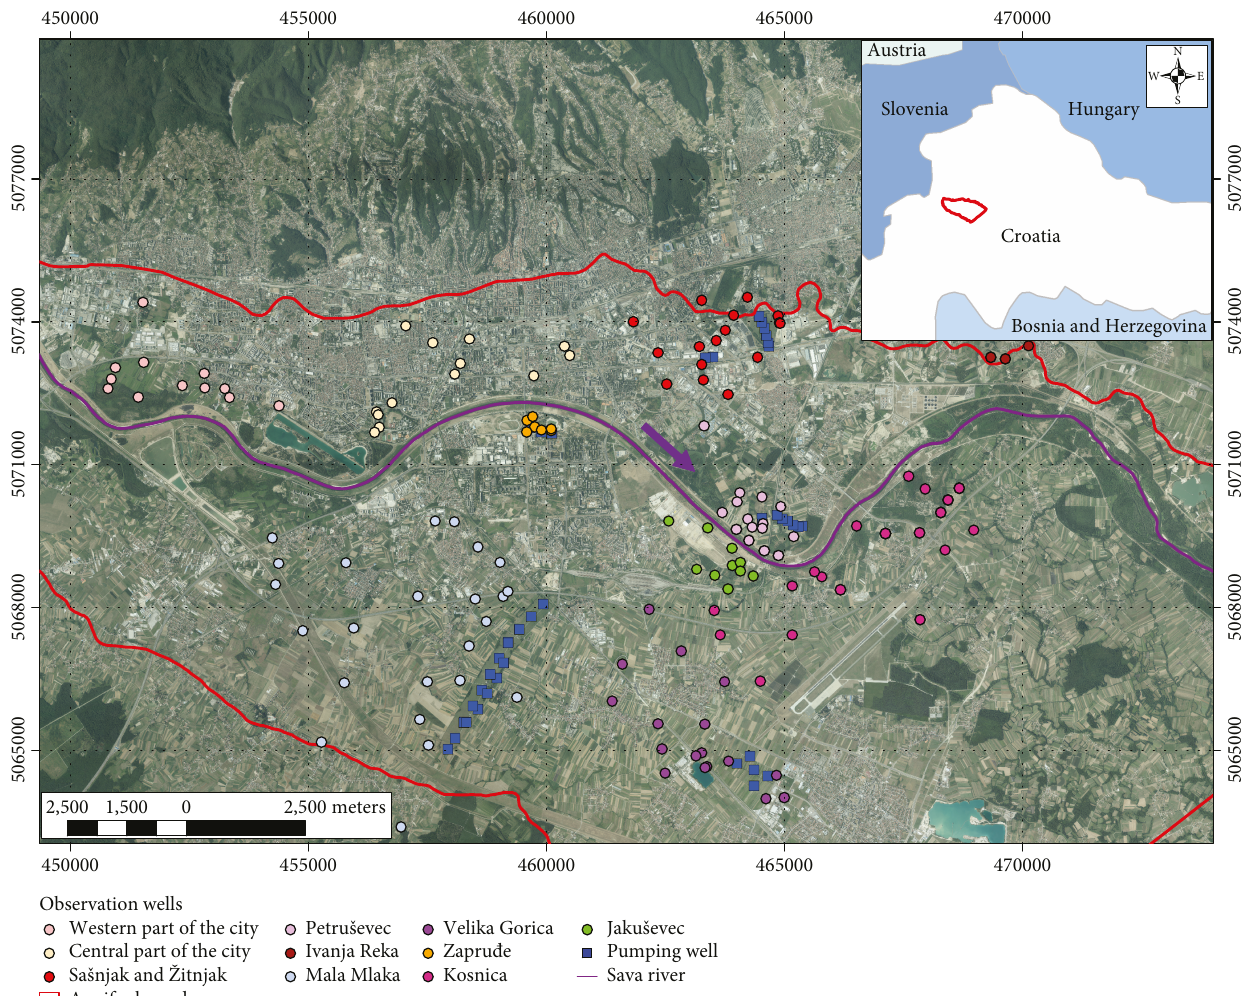
Figure 1: Research area and spatially grouped observation